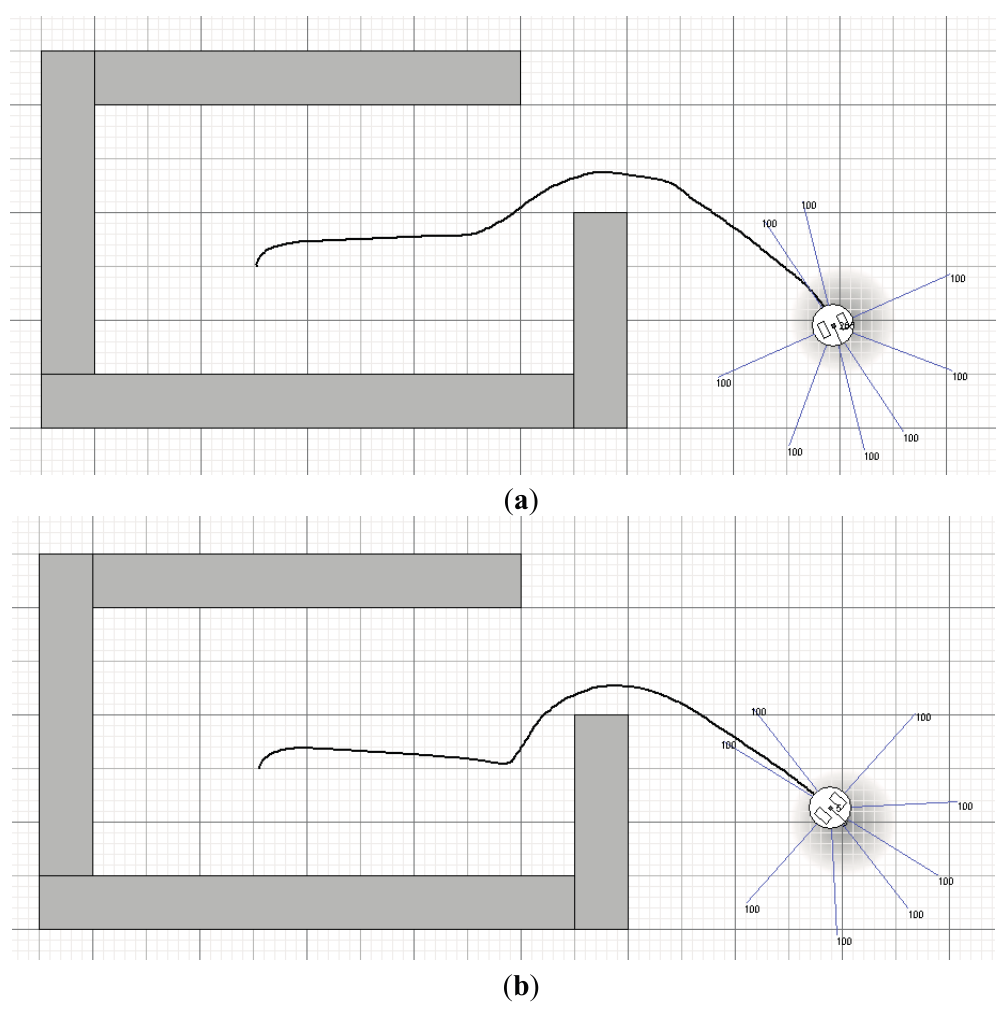
Figure 26. Path I obtained when the navigation when the fixed sampling period is large ( a ) and Path II when the fixed sampling period is short ( b